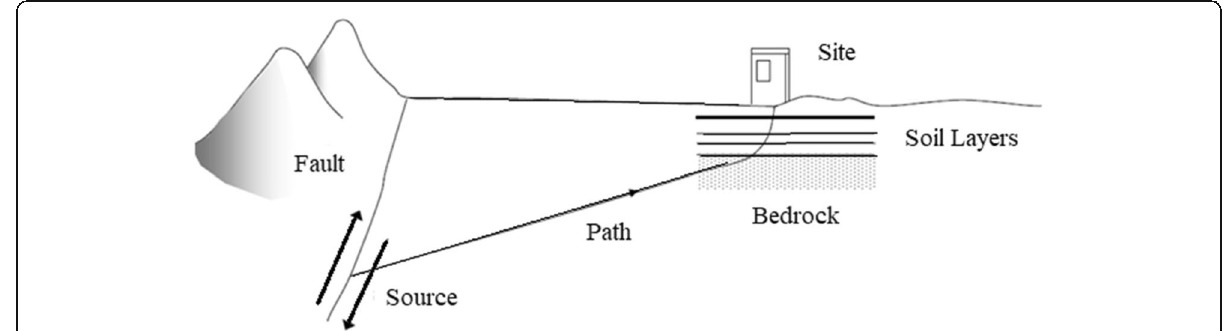
Fig. 2 Ground motion at source, path and Geology (Kramer